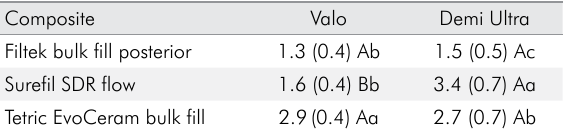
Table 4. Mean (±SD) x 10 7 of volume loss (µm 3 ) of bulk fill composites after